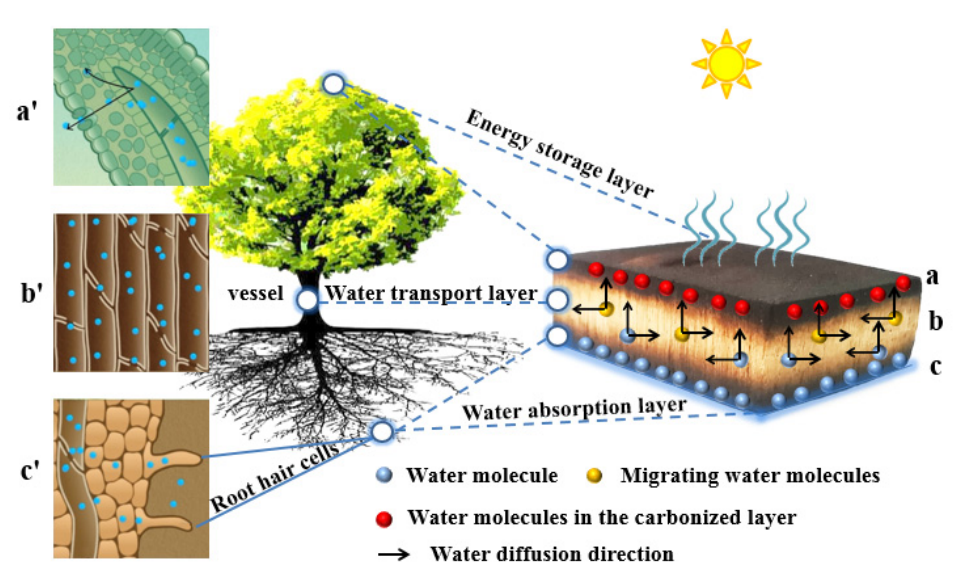
Figure 7. Water migration map of double-sided carbonized poplar specimens corresponding to plants. ( a ) The photothermal energy storage layer corresponding to the transpiration effect of plant leaves ( a’ ); ( b ) the water transport layer corresponding to the water migration effect of plant ducts ( b’ ); ( c ) the water absorption layer corresponding to the water absorption effect of tree roots ( c’ ).